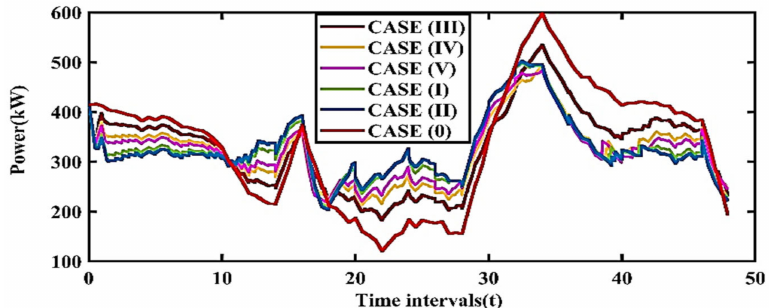
Figure 9. Grid power deviation for different case studies.